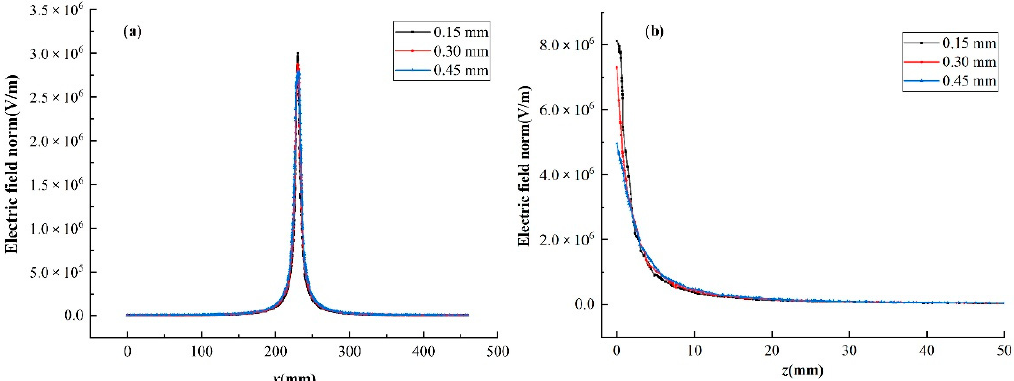
Figure 4. Electric field intensity of electrospinning setups for different needle thickness with a receiving distance of 150 mm. ( a ) electric field intensity along the x -axis at 2 mm below the needles and ( b ) electric field intensity along the z -axis.